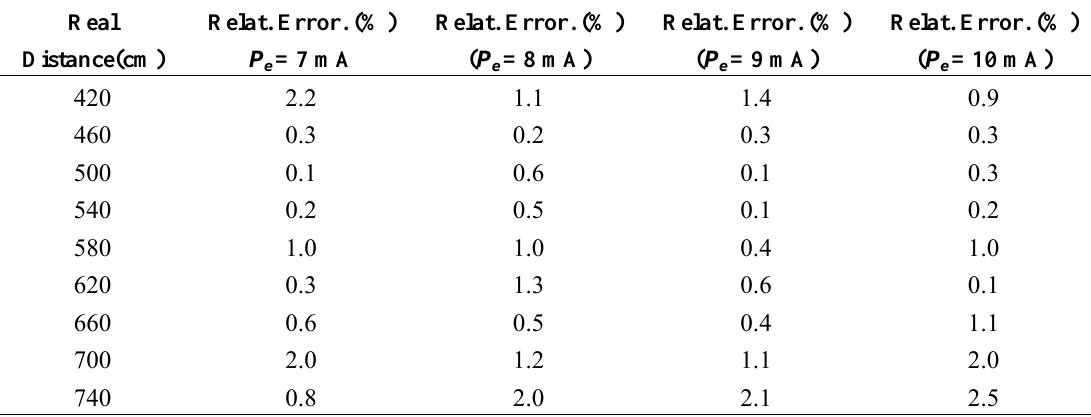
Table 4 . Relative error on distance estimation for the second